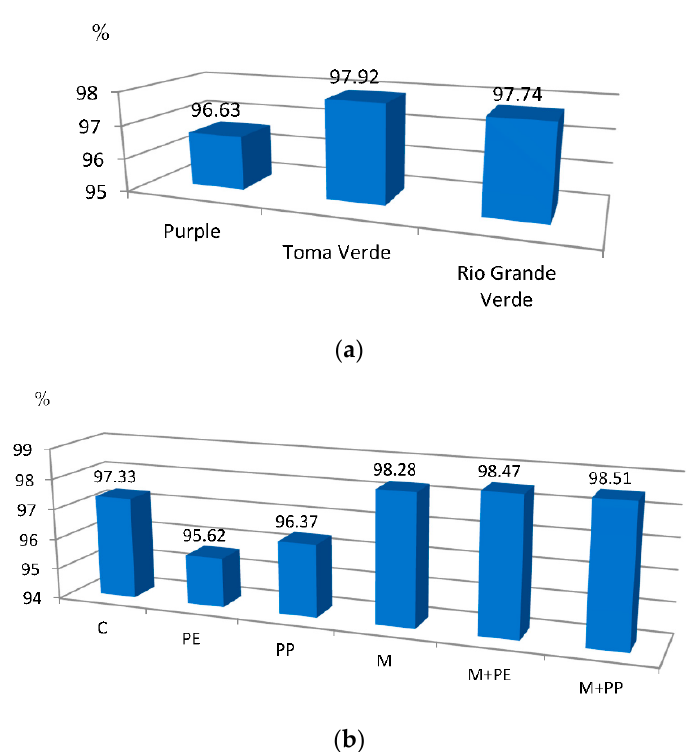
Figure 8. The effects of cultivar ( a ), plant covers and mulching ( b ) on the marketable yield of tomatillo fruit expressed as a percentage of total yield (means of 2015, 2017–2018). Explanation: C—control; PE—perforated PE film with 100 openings per m 2 for covering field beds (PE); PP—non-woven PP fabric with surface density of 17 g m − 2 for covering field beds; M—black PE film with a thickness of 0.05 mm for mulching; M + PE—black PE film with a thickness of 0.05 mm for mulching + perforated PE film with 100 openings per m 2 for covering field bed; M + PP—black PE film with a thickness of 0.05 mm for mulching + non-woven PP fabric with surface density of 17 g m − 2 for covering field